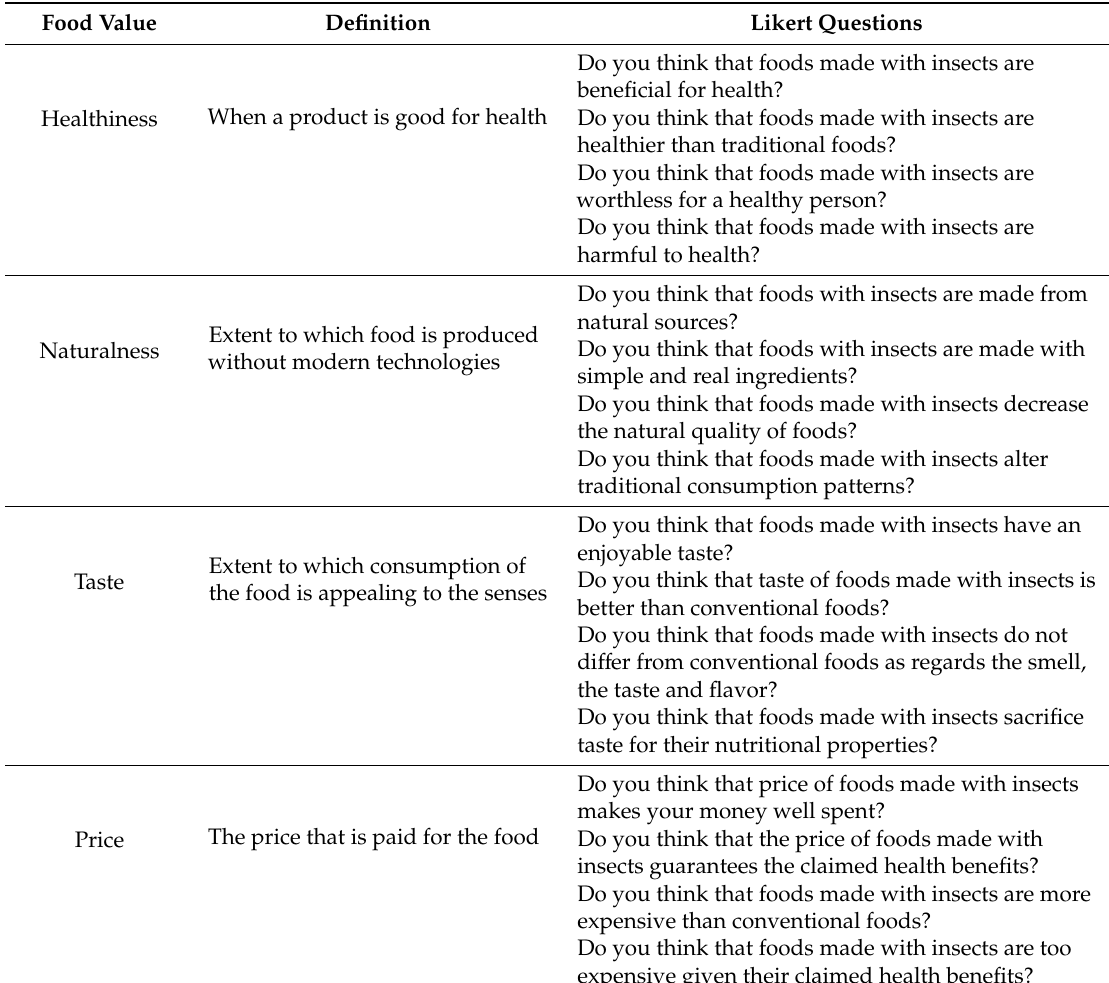
Table A1. Food values: Likert scale and